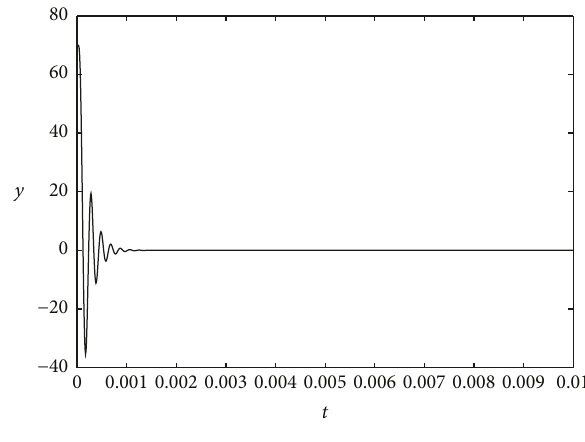
Figure 3: Problem (43)–(46): vanishing 𝑦 𝑛 .